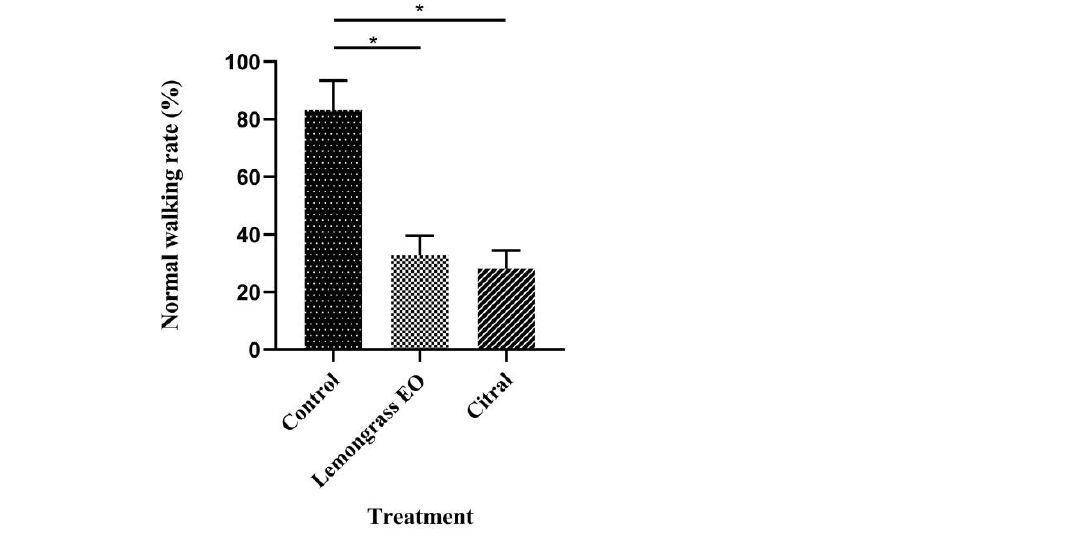
Figure 1. Effect of lemongrass EO and its major constituent on the walking behavior of R. flaviceps workers. Means ( ± SD) values with * show significant differences ( p < 0.01), according to Tukey’s HSD test.